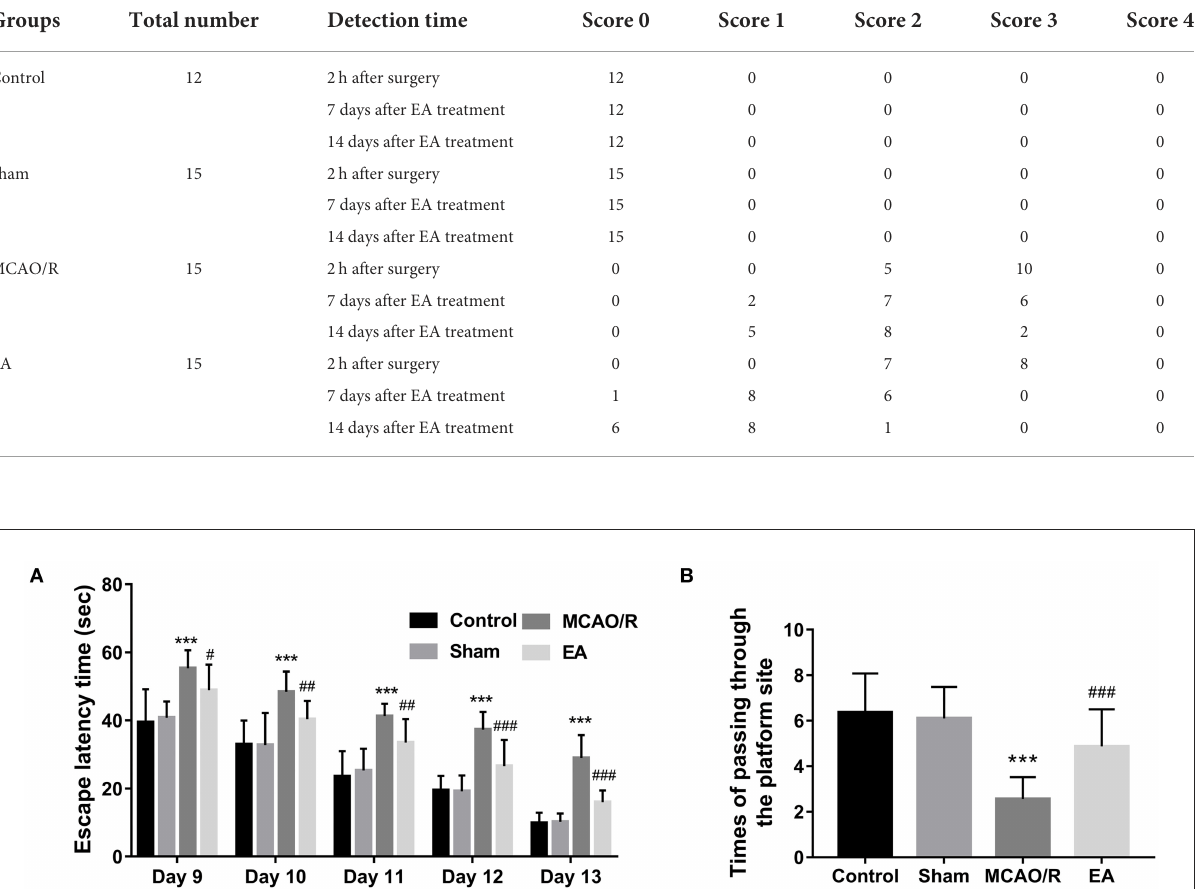
PAK4, AKT3, Pten, Nrp2, and Efnb2, in response to